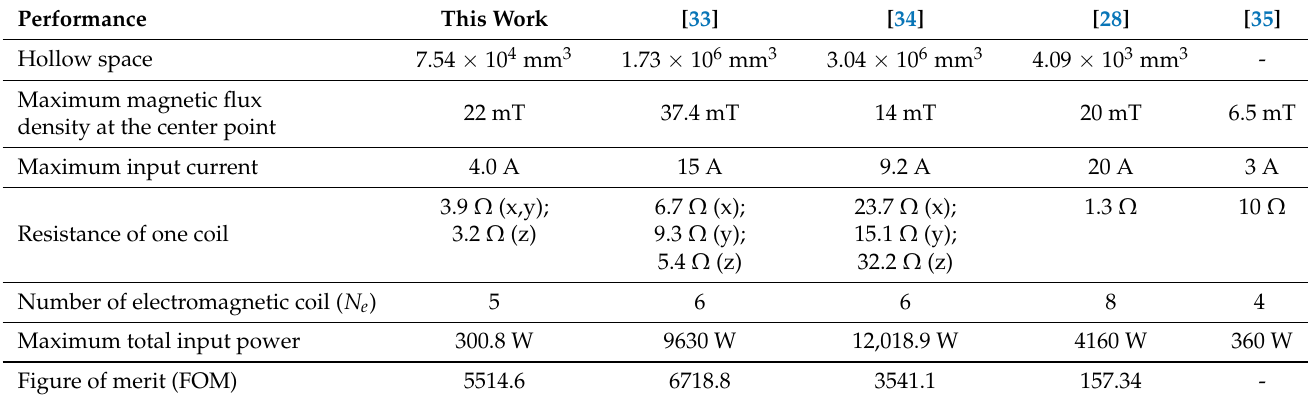
Table 3. Performance comparison with existing alternating magnetic actuation